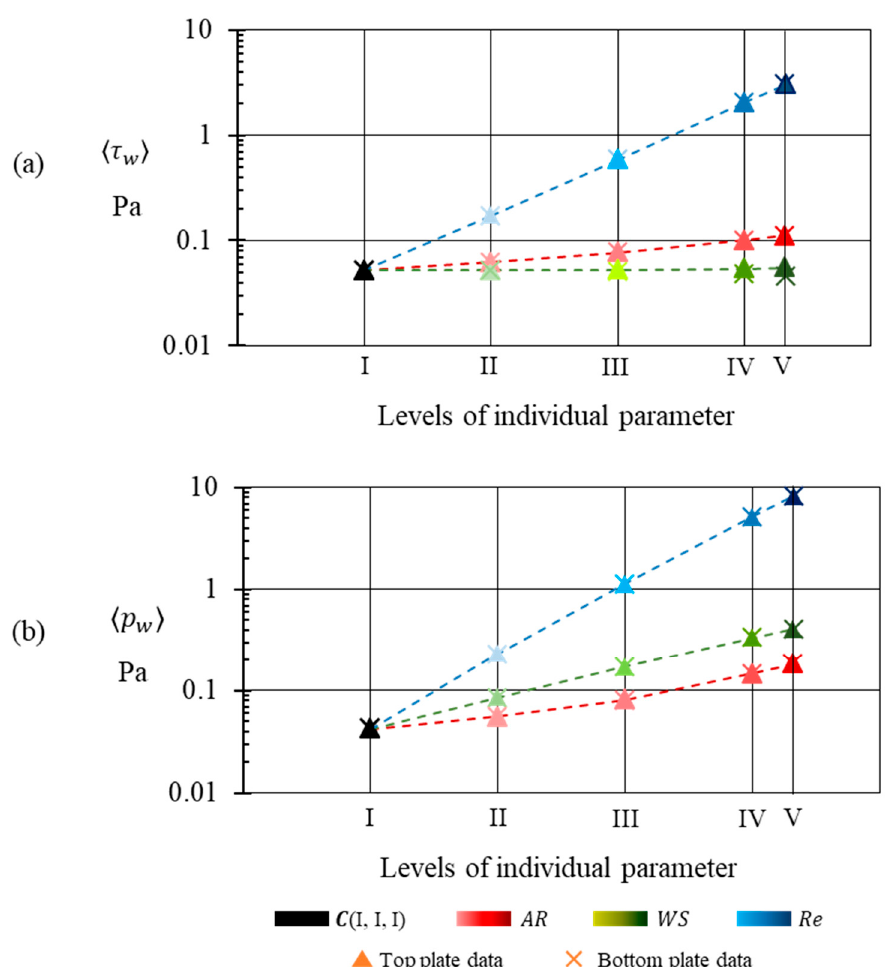
Figure 11. Influence of parameters on the wavelength-average of ( a ) shear stress and ( b ) pressure on the top and bottom walls. Data for parameter-variation is color-coded as shown in the legend. Additionally, triangles of any color denote data is plotted for the top plate, while cross marks denote data is plotted for the bottom plate. The abscissa is set to display the levels on a logarithmic scale.